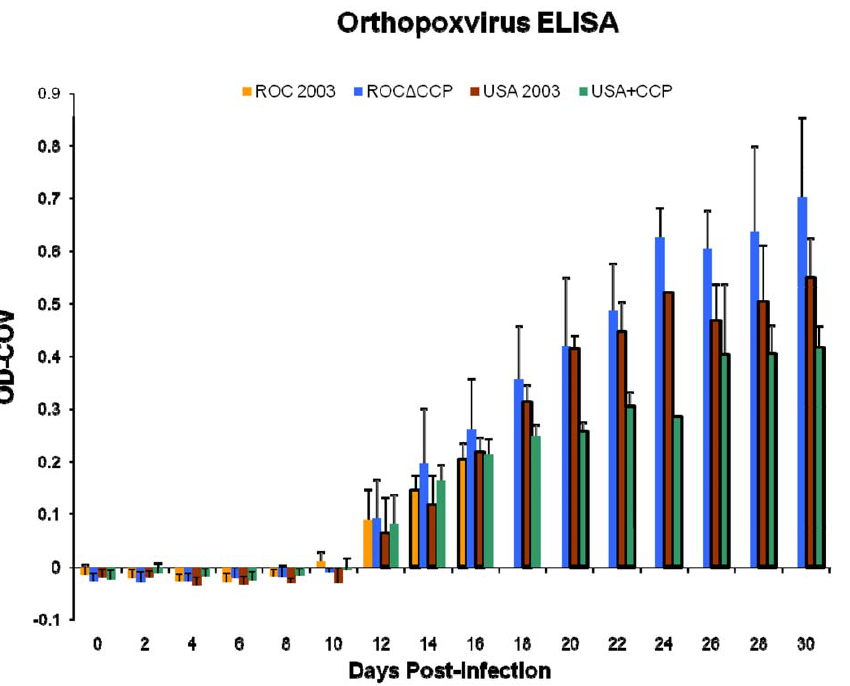
Figure 8. Anti-orthopoxvirus antibody production. Orthopoxvirus specific ELISA to detect total IgG. The average value per infection group is shown here. The reported OD-COV (cutoff value) corresponds to the value above the average signal of the negative control wells plus two standard deviations. None of the average OD-COVs were significantly different between groups within a sample day (p . 0.05). Dark bar borders indicate n , 4 for the mean generated on that day.